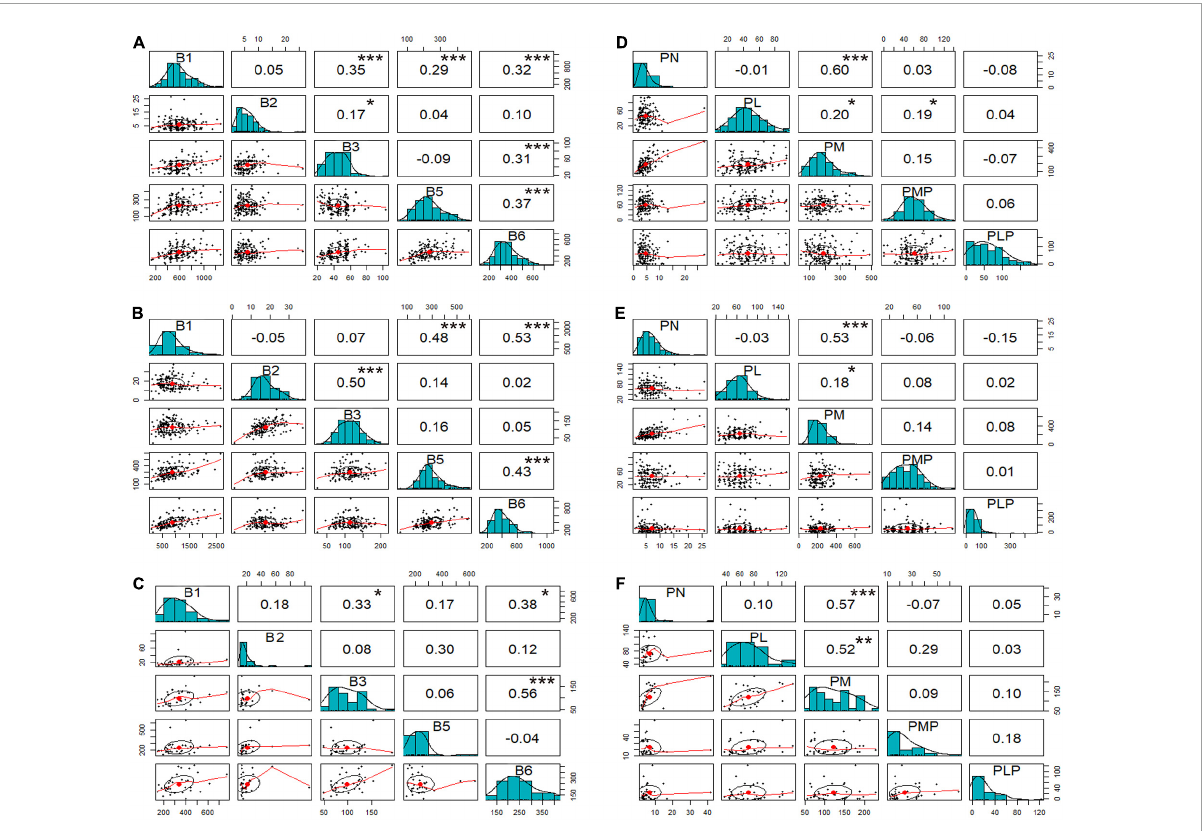
FIGURE2 Scatter plots and correlation analysis among vitamin B. For each plot, the upper diagonal represents the correlation coefficient; *, **, and *** represent significance at p < 0.05, 0.01, and 0.001, respectively. Lower diagonal plots show the vitamin distribution. Plots: (A) vitamin B1, B2, B3, B5, and total B6 in Hainan; (B) vitamin B1, B2, B3, B5, and total B6 in Hebei; (C) vitamin B1, B2, B3, B5, and total B6 of hybrids; (D) derivatives of B6 in Hainan; (E) derivatives of B6 in Hebei; (F) derivatives of B6 in hybrids. B1, thiamine; B2, riboflavin; B3, niacinamide; B5, pantothenic acid; and B6, total of pyridoxine and derivatives; PL, pyridoxal; PLP, pyridoxal 5’-phosphate; PM, pyridoxamine; PMP, pyridoxamine-5’-phosphate; PN,